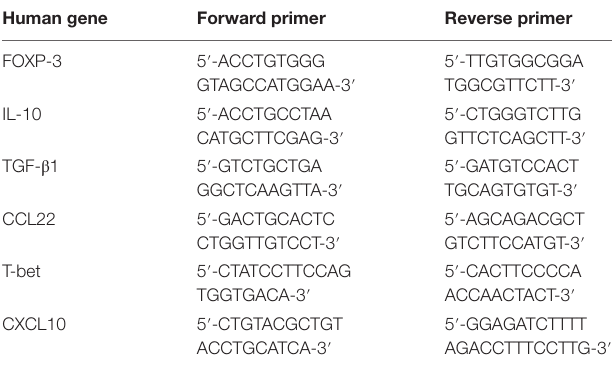
Table 1 | List of primers specific for human genes used in qPCR